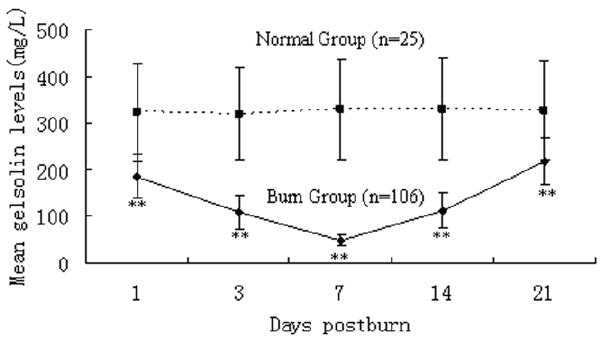
Figure 1. Time course of pGSN levels after burn injury. Time course of pGSN levels after burn injury. Mean pGSN levels were significantly decreased during PBD 1–21 compared with normal controls (all P , 0.01), and there was a significantly lower level of pGSN on PBD 7 compared with other time points. **P , 0.01, burn group vs. normal